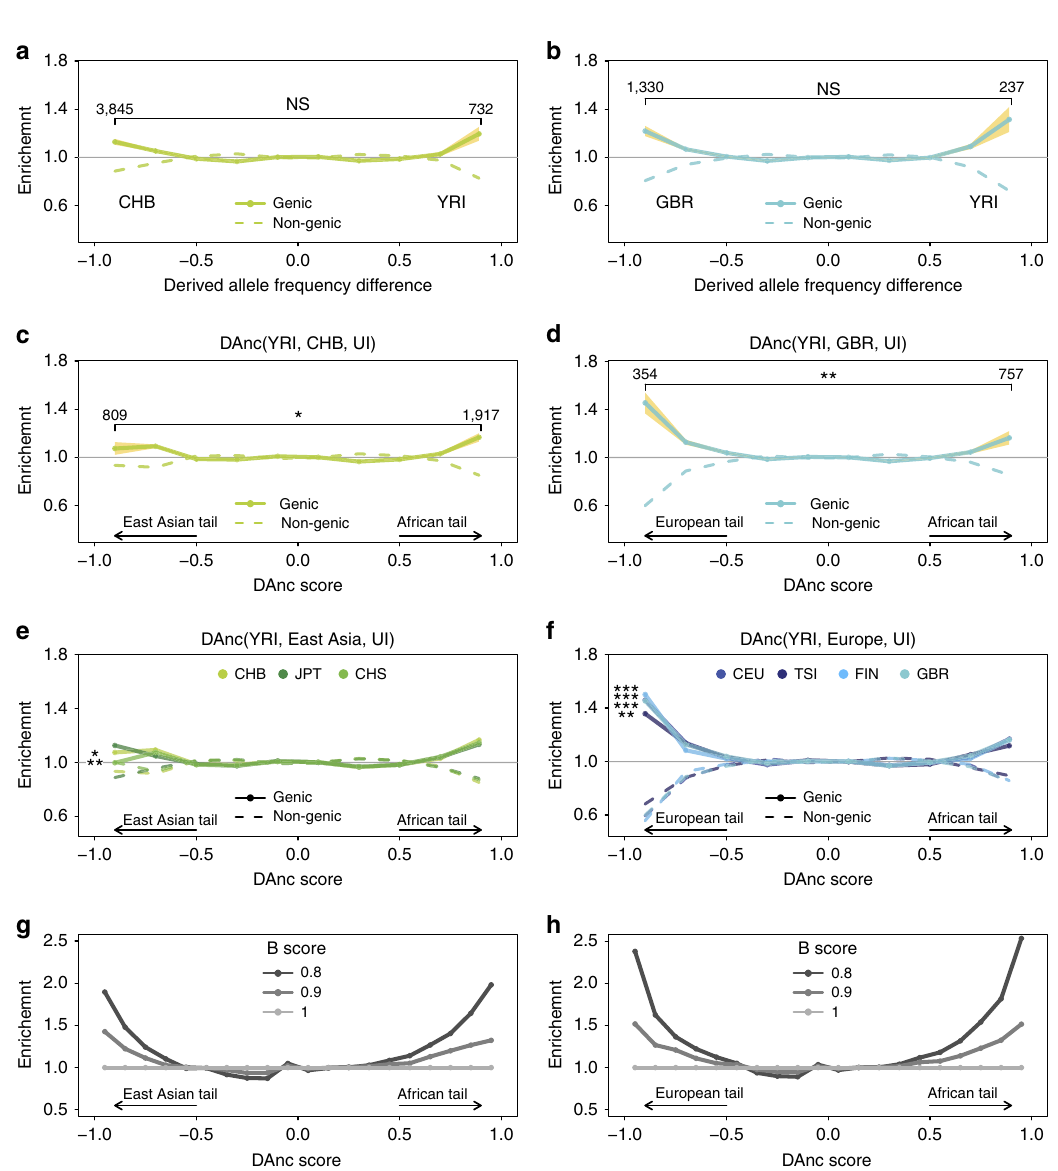
Figure 1 | Analyses of population differentiation. ( a , b ) Genic enrichment among alleles in different bins of population differentiation between ( a ) CHB or ( b ) GBR and YRI. The bootstrap 95% confidence interval is shown in yellow, and the level of significance of the bias in genic enrichment when comparing the two tails is shown on top (* P o 0.05, ** P o 0.01 and *** P o 0.001, and NS non-significant). The number of genic sites in each tail is on top of the tails. ( c , d ) Genic enrichment in alleles in different bins of the DAnc statistic (YRI, P 2 , Ust 0 -Ishim (UI)) using ( c ) CHB or ( d ) GBR as P 2 . The 95% confidence interval, the significance of the bias, and the number of genic alleles are shown as above. ( e , f ) Genic enrichment in alleles in different bins of the DAnc statistic when considering each East Asian ( e ) or European ( f ) population as P 2 , with significance of the bias between the tails indicated by asterisks (* o 0.05, ** o 0.01 and *** o 0.001). ( g , h ) Expectation of the genic enrichment across the DAnc distribution under non-adaptive forces, based